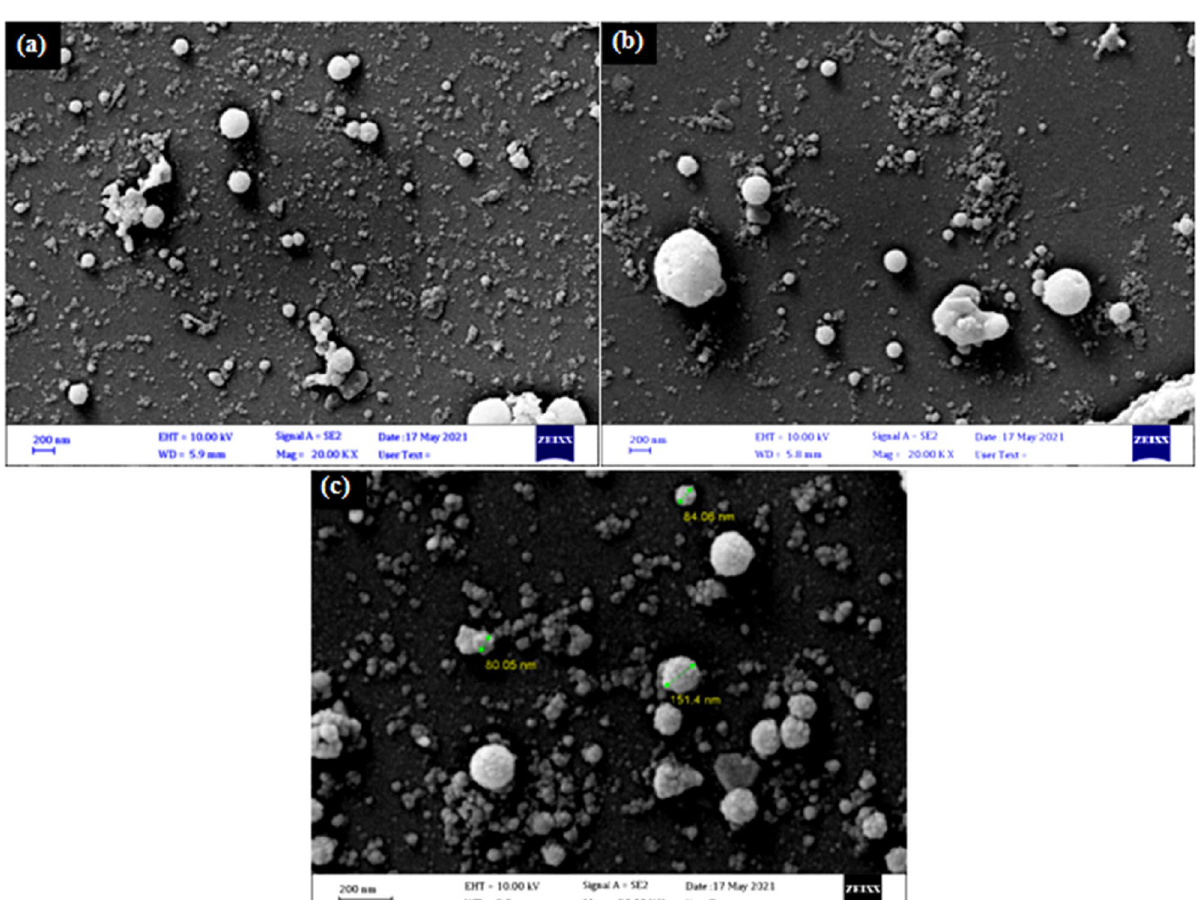
Figure 4. FESEM images of B 4 C NPs synthesized at different laser pulses prepared at ( a ) 500, ( b ) 1000, and ( c ) 1500